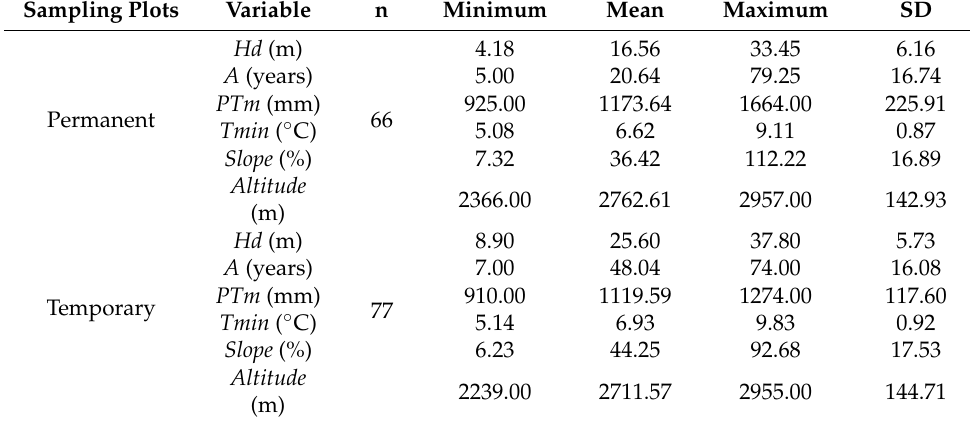
Table 1. Descriptive statistics of the data used in fitting dynamic equations for patula pine. Sampling Plots Variable